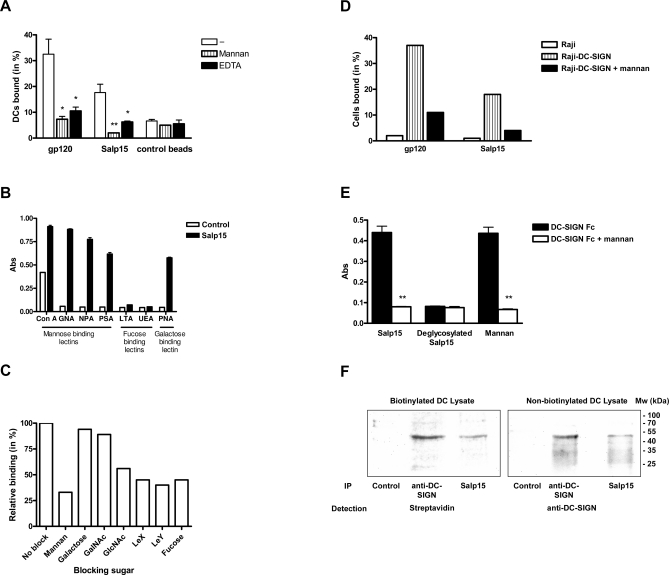
Salp15 Interacts with DCs through the C-Type Lectin DC-SIGN(A) Salp15 binds to DC-SIGN on DCs. A fluorescent bead adhesion assay was performed using fluorescent beads coated with HIV-1 gp120 (positive control) and Salp15. As negative control beads we used antibody (anti-V5) coated beads. Immature DCs were incubated with the ligands and binding was measured by FACS analysis. Specificity was determined by preincubation of DCs with EDTA or mannan (significance determined by a two-sided one way ANOVA, implementing a one way analysis of variance and a Dunnett multiple comparison test).(B) Salp15 contains mannose and galactose-specific glycosylations. The glycosylation pattern of Salp15 was analysed by a plant lectin ELISA. For abbreviations see Materials and Methods.(C) Salp15 binding to DCs is inhibited by carbohydrates that interact with DC-SIGN. Specificity of binding of DCs to Salp15 was further assessed by pretreating DCs with mannan, free carbohydrate structures (Galactose, N-acetylgalactosamine [GalNac], N-acetyl-D-glucosamine [GlcNac], or Fucose), or biotinylated Lewis-X/Y (LeX/Y) before performing the fluorescent bead adhesion assay as described in (A). Salp15 binding was set at 100%.(D) Salp15 interacts specifically with DC-SIGN. The fluorescent bead adhesion assay was performed using the Raji-cell line transfected with DC-SIGN. Mannan and EDTA was used to determine specificity for C-type lectins.(E) Glycosylation of Salp15 is important in the interaction with DC-SIGN. A DC-SIGN-Fc binding ELISA was performed on Salp15, deglycosylated Salp15 (by incubation with PGNaseF), and mannan (positive control). For Salp15 and mannan DC-SIGN-Fc binding could be blocked by preincubation with mannan (significance determined by a two-sided unpaired Student t-test).(F) DC-SIGN is the major receptor on immature DCs for Salp15. Both a cell-surface biotinylated and non-biotinylated DC lysate were incubated with Salp15-coupled protein A-Sepharose beads. The biotinylated immunoprecipitate was analysed on SDS-PAGE, transferred to a nitrocellulose membrane, and detected by streptavidin-PO. The non-biotinylated immunoprecipitate was analyzed by SDE-PAGE, transferred to a nitrocellulose membrane, and detected by anti-DC-SIGN antibodies. As controls, anti-DC-SIGN protein A-Sepharose beads and anti-V5-protein A-Sepharose beads were used.Adhesion experiments and ELISAs are representative of at least three independent experiments. Error bars, where depicted, represent the SE of duplicates or triplicates within one experiment. A p-value < 0.05 was considered statistically significant. (*) 0.01 < p < 0.05; two asterisks (**) 0.001 < p < 0.01. The immunoprecipitations are representative of two experiments.